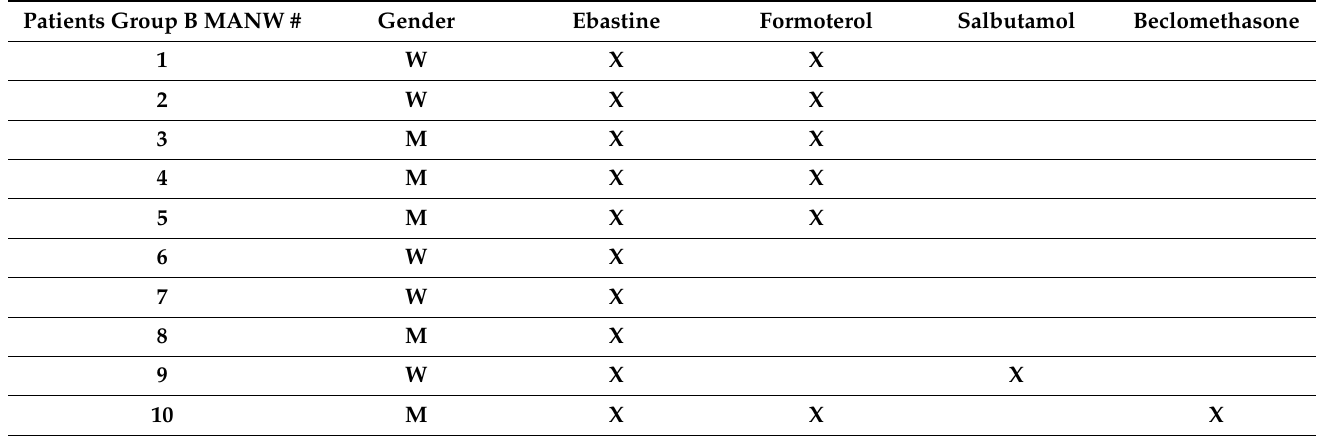
Table 2. Pharmacological treatments of enrolled asthmatics Group B MANW.